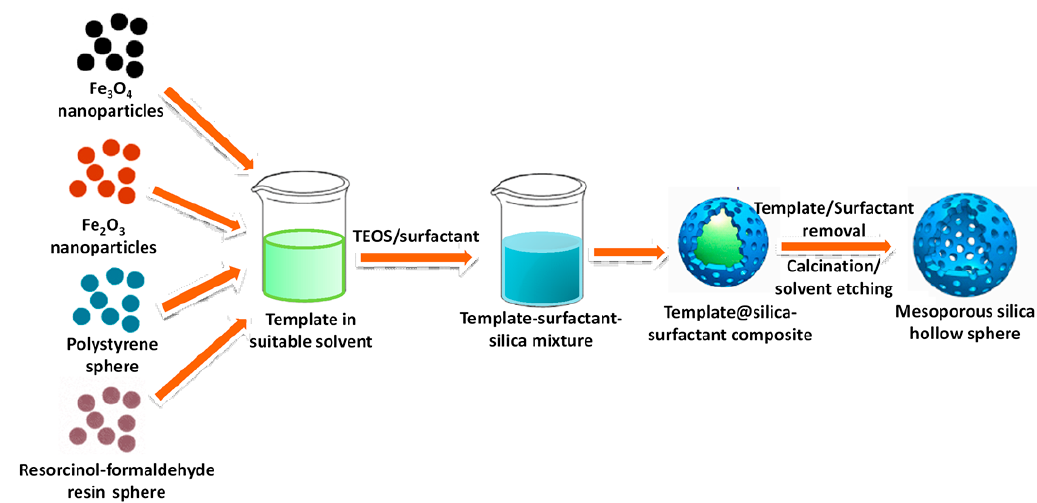
Figure 6. A comprehensive outline of hollow mesoporous silica (HMS) synthesis using various templates and CTAB surfactant.